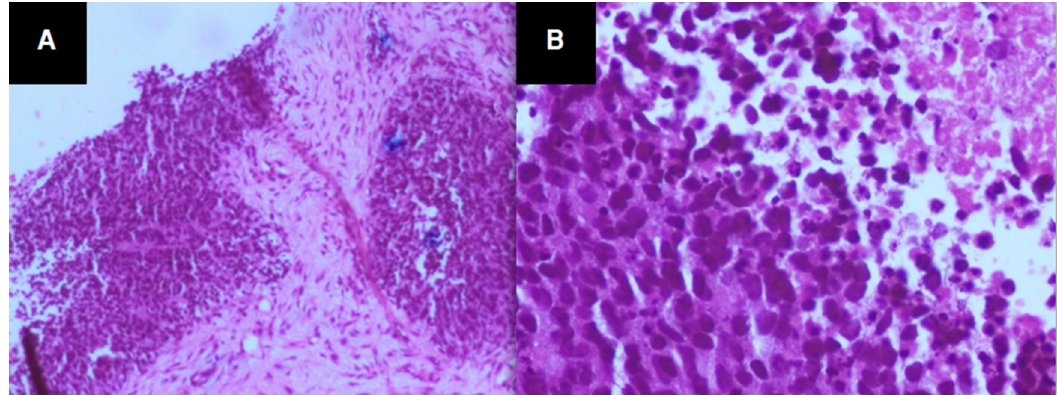
Fig. 2. (A and B) Histopathological sections showing tumour cells arranged in sheets with scanty cytoplasm and oval nucleus with coarse chromatin (H&E stain; original magni fi cation, (cid:1) 400; (cid:1) 100).